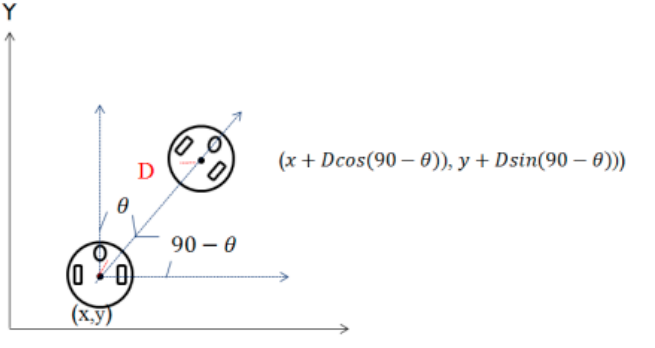
Figure 12. Robot position estimation.